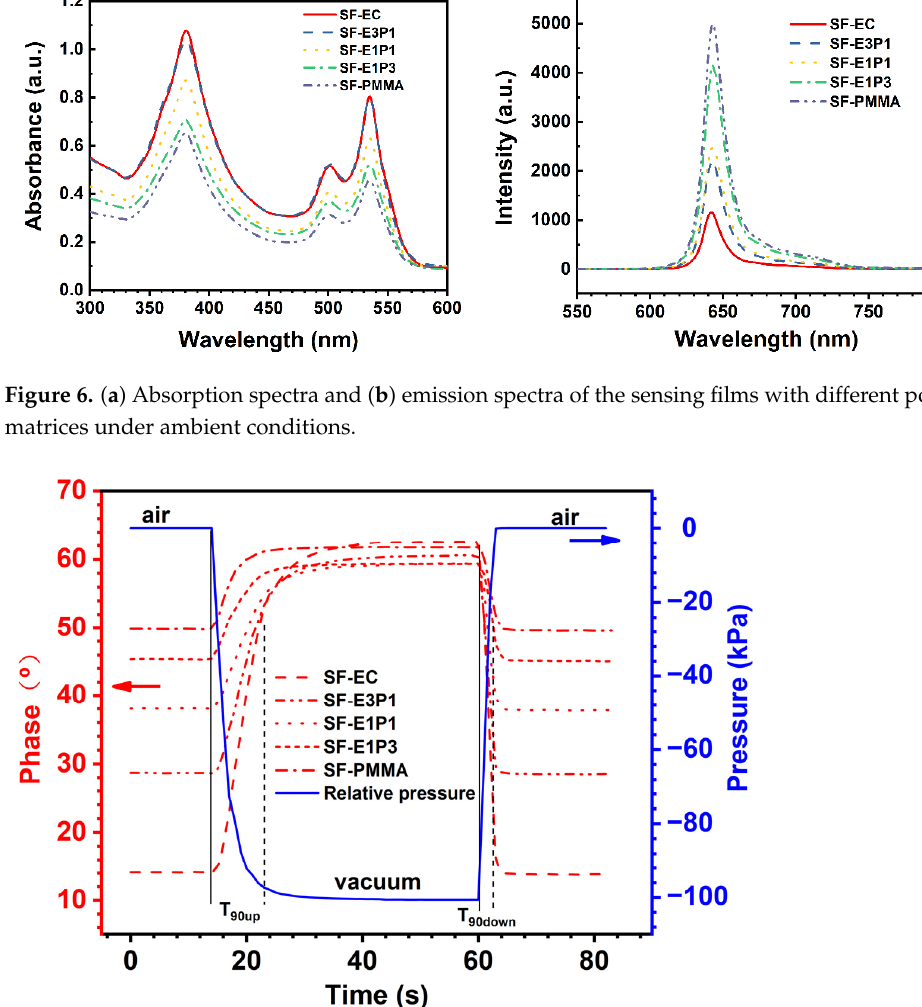
Figure 6. ( a ) Absorption spectra and ( b ) emission spectra of the sensing films with different poly- mer matrices under ambient conditions.